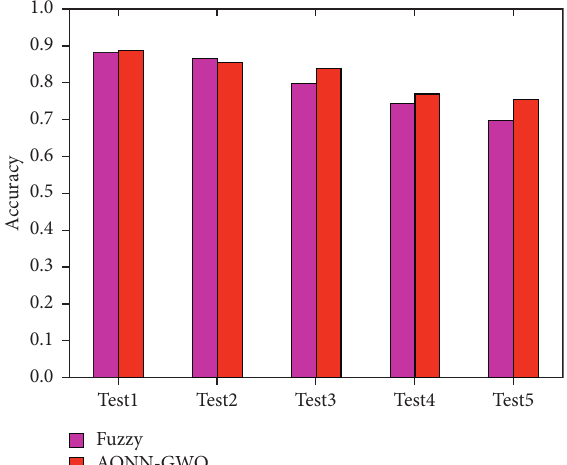
Figure 4: Comparative analysis of accuracy result.